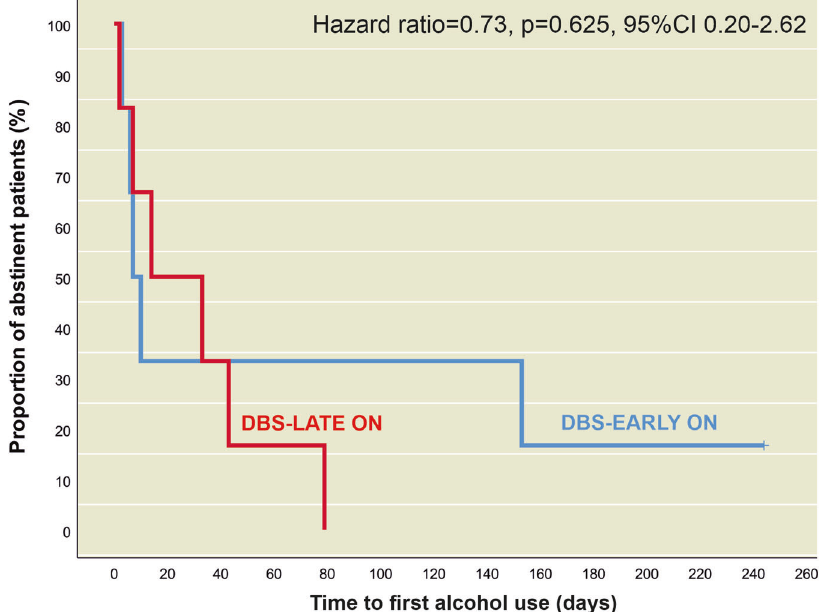
Fig. 3 Effect of NAc DBS on time to fi rst alcohol use. Kaplan – Meier curves illustrating the time until fi rst alcohol use after randomization (primary outcome) in the active stimulation group (DBS EARLY-ON) and sham stimulation group (DBS LATE-ON), which did not differ signi fi cantly between both groups (95%CI = 95% Con fi dence